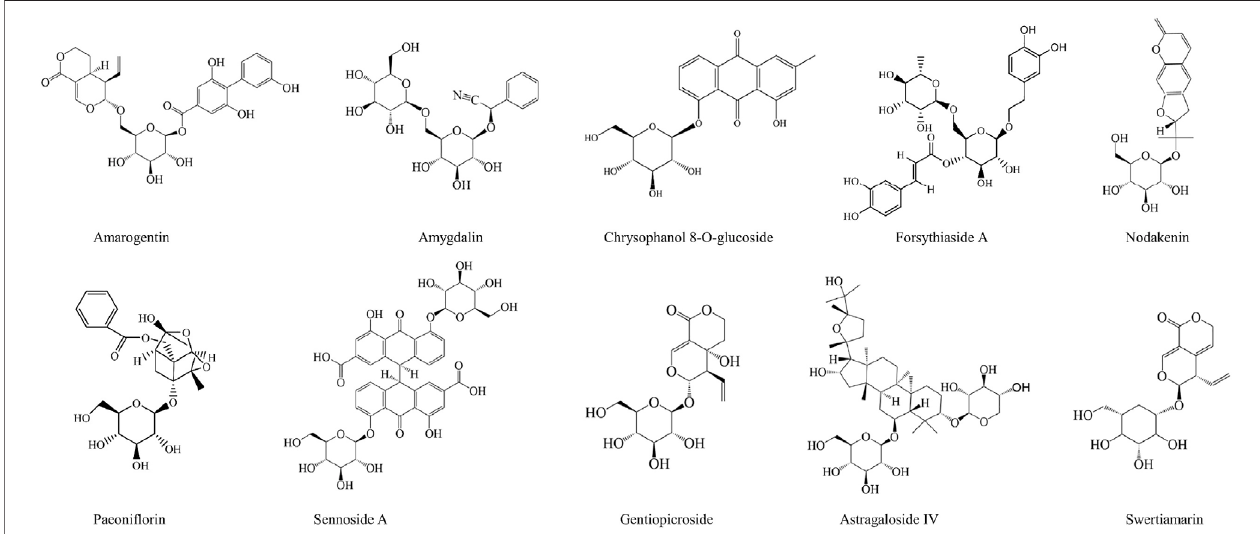
FIGURE 5 | The chemical structures of glycosides showing anti-hepatopathy activity.